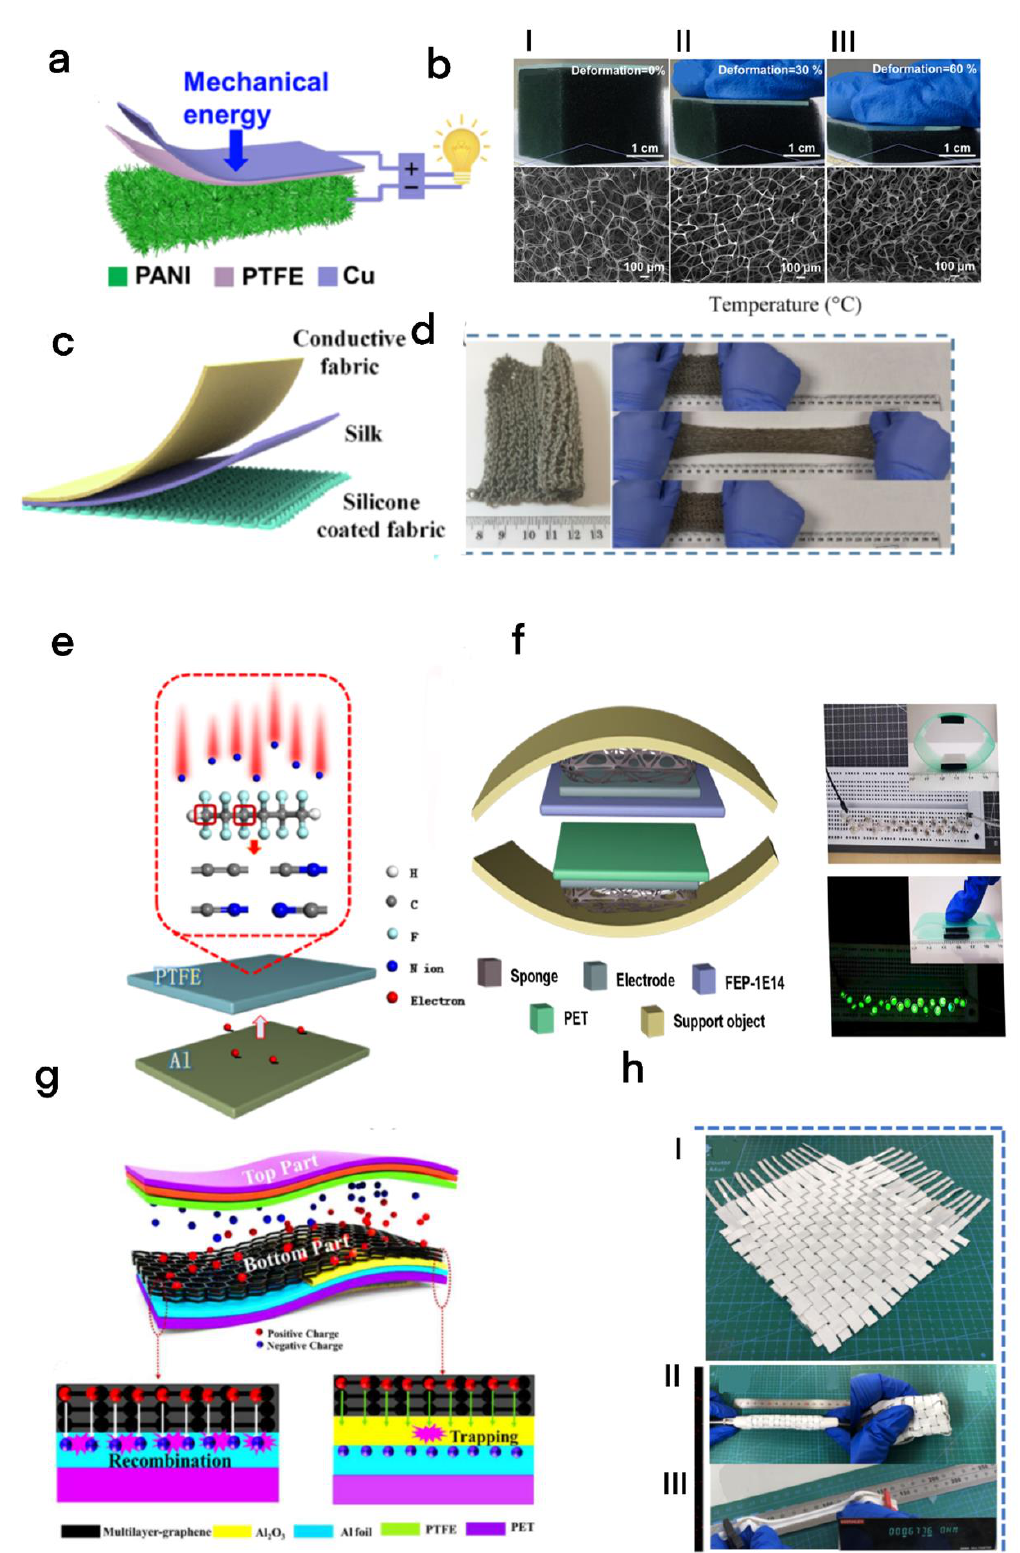
Figure 3. ( a ) Schematic representation of the ES-TENG. ( b ) (I – III) The optical and SEM pictures of a conductive flexible sponge with various compressive strains [35]. Liu et al. (2020), Elsevier. ( c ) Fabric TENG device structure for collecting acoustic energy. ( d ) Photos showing the elasticity of knitted fabrics [36]. Cao et al. (2022), Elsevier. ( e ) Schematic representation of TENG composed of Al and PTFE modified by ion implantation. ( f ) The left half is the schematic diagram of the equipment. The